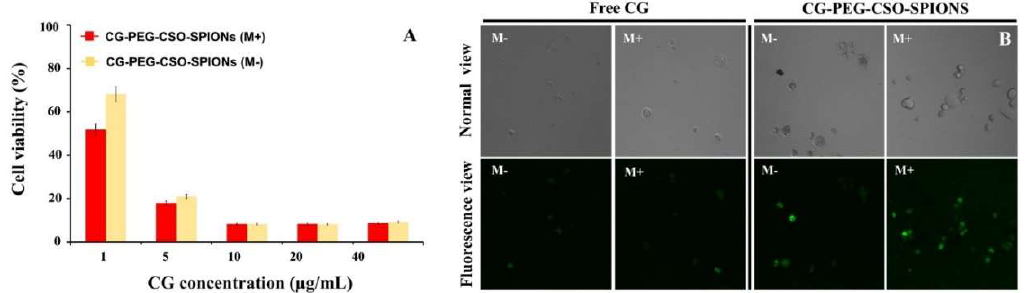
Figure 13. Magnetic targeting delivery analyzed in terms of the ( A ) HT-29 cell viability using the MTT assay (data are shown as the mean ± SD, derived from 3 trials) and ( B ) representative CLSM images of HT-29 cells after incubation with free CG or CG-PEG-CSO-SPIONs at 40 µg CG/mL for 24 h with (M+) or without (M−) an external magnetic field.